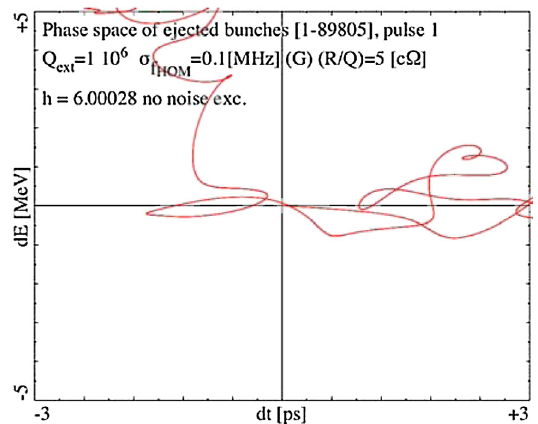
FIG. 40. (Color) Phase-space image of the ejected bunches of the second pulse. Conditions as Figs. 38 and 39 but Q ext ¼ 10 6 . The pulse was aborted after about 90 000